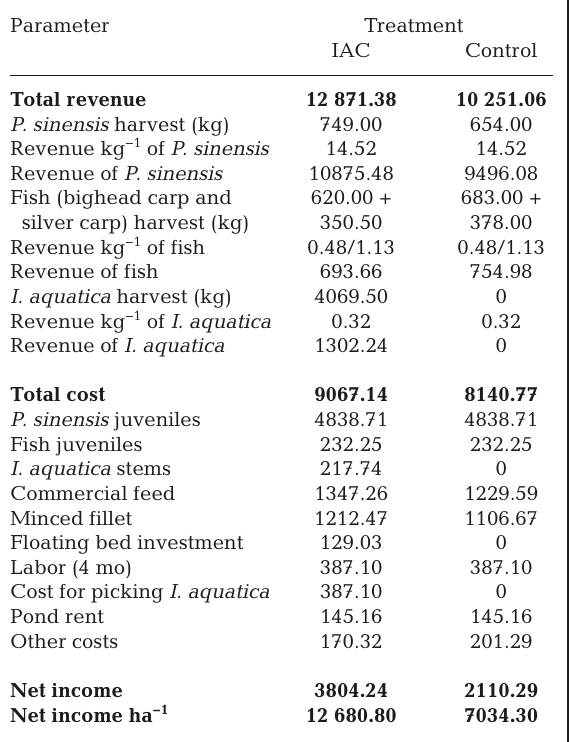
Table 2. Cost and return analysis of Chinese soft-shelled turtle Pelodiscus sinensis cultured for 4 mo under 2 differ- ent treatments in ponds. IAC: Ipomoea aquatica treatment. Values are in US dollars ($1.00 US = $6.20